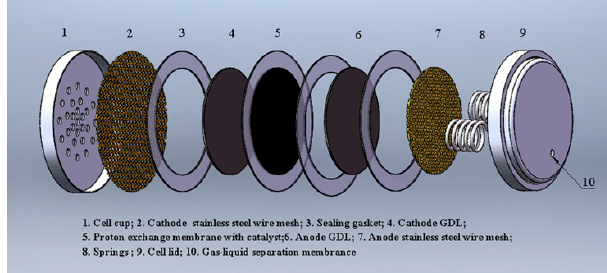
Figure 2. The layout of the 3DG + S B- µ DMFC.